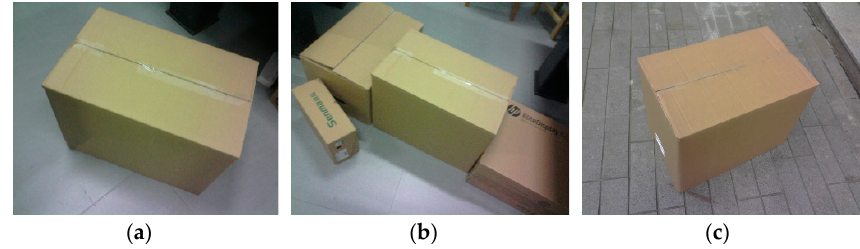
Figure 15. Measured box in different scenarios; ( a ), ( b ) and ( c ) are three boxes in different scenarios.